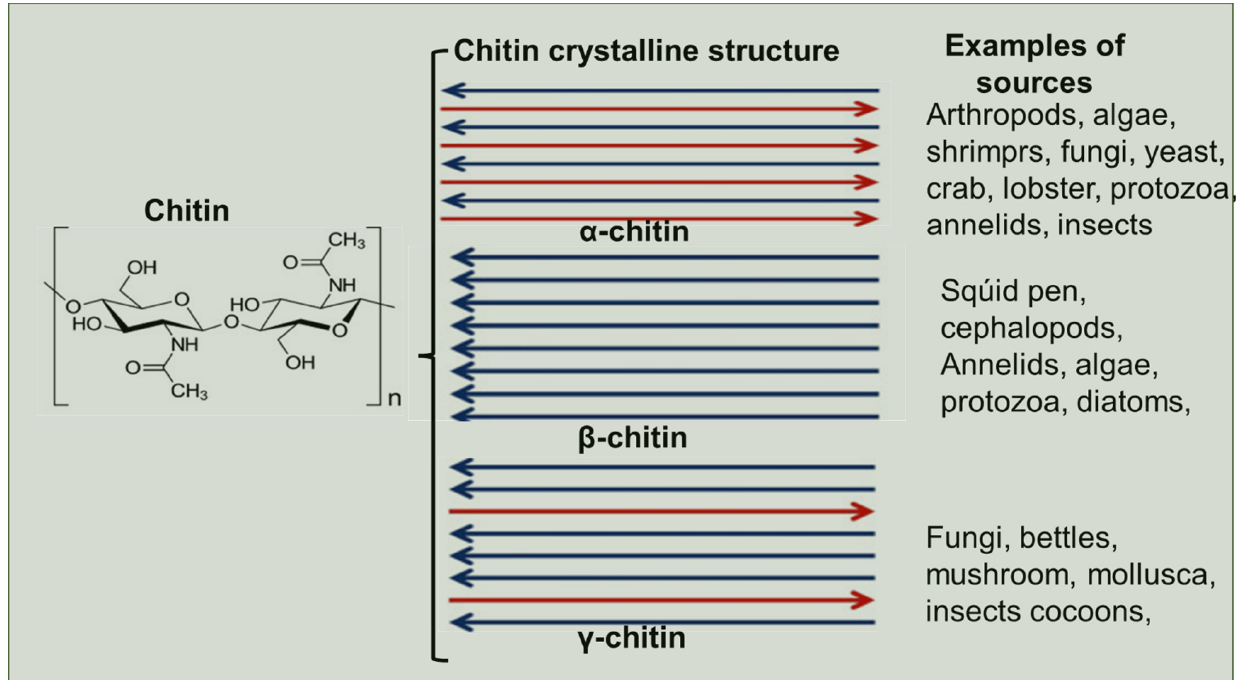
Figure 3. Orientation and arrangement of chitin microfibrils in α -, β - and γ -chitin [81].